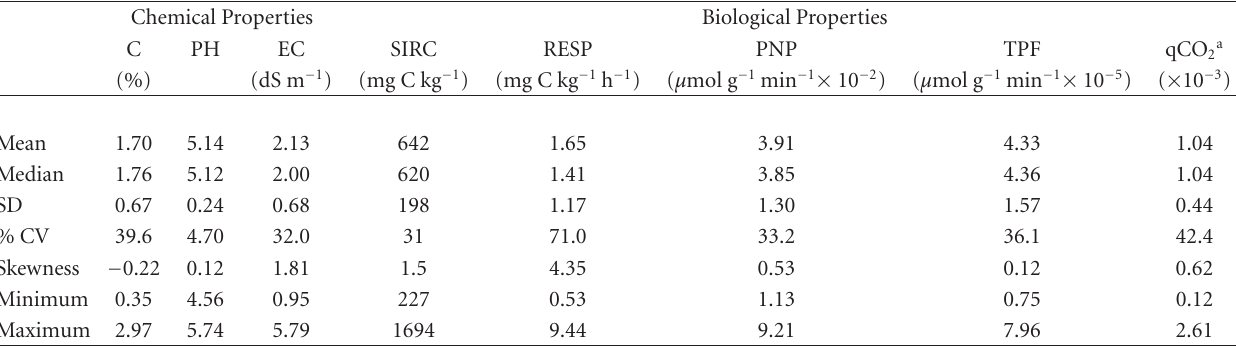
Table 1: Univariate statistics for measured soil properties ( n = 220). Total C, pH, EC: electrical conductivity; SIRC: microbial biomass C by substrate-induced respiration; RESP: nonamended soil respiration; PNP: phosphatase activity; TPF, dehydrogenase activity and qCO 2 , metabolic quotient.